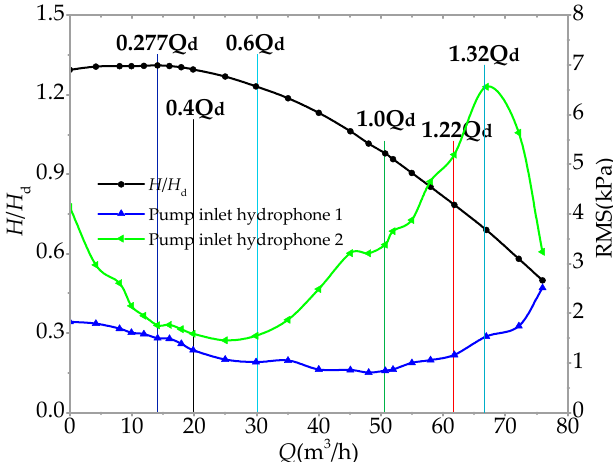
Figure 12. Root mean square (RMS) of the pump inlet acoustic pressure under different flow rates.